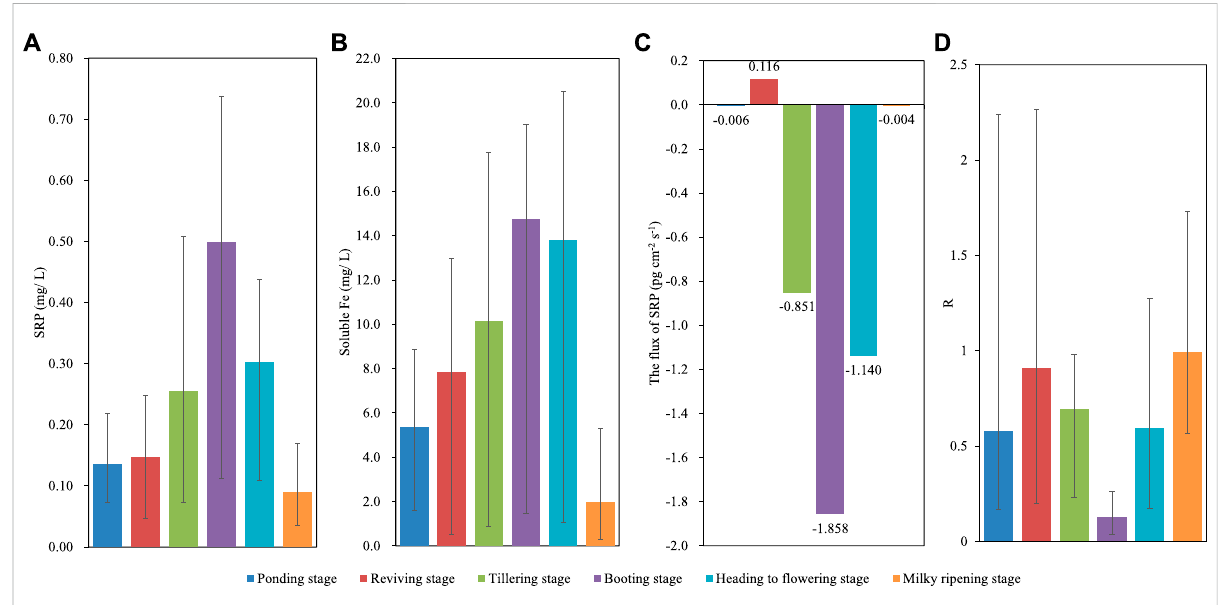
FIGURE 5 Soil vertical SRP and soluble Fe during the whole rice reproductive stage (A) average concentration of DGT-labile P, (B) average concentration of DGT-labile Fe, (C) SRP fl ux across to SWI and (D) the ratio R of labile P to